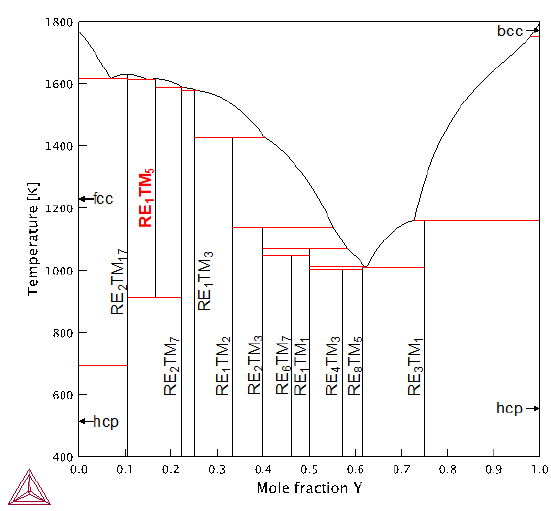
Figure 3. The Y-Co phase diagram calculated using the CALPHAD assessment presented in this study. Here, RE = Y and TM = Co.